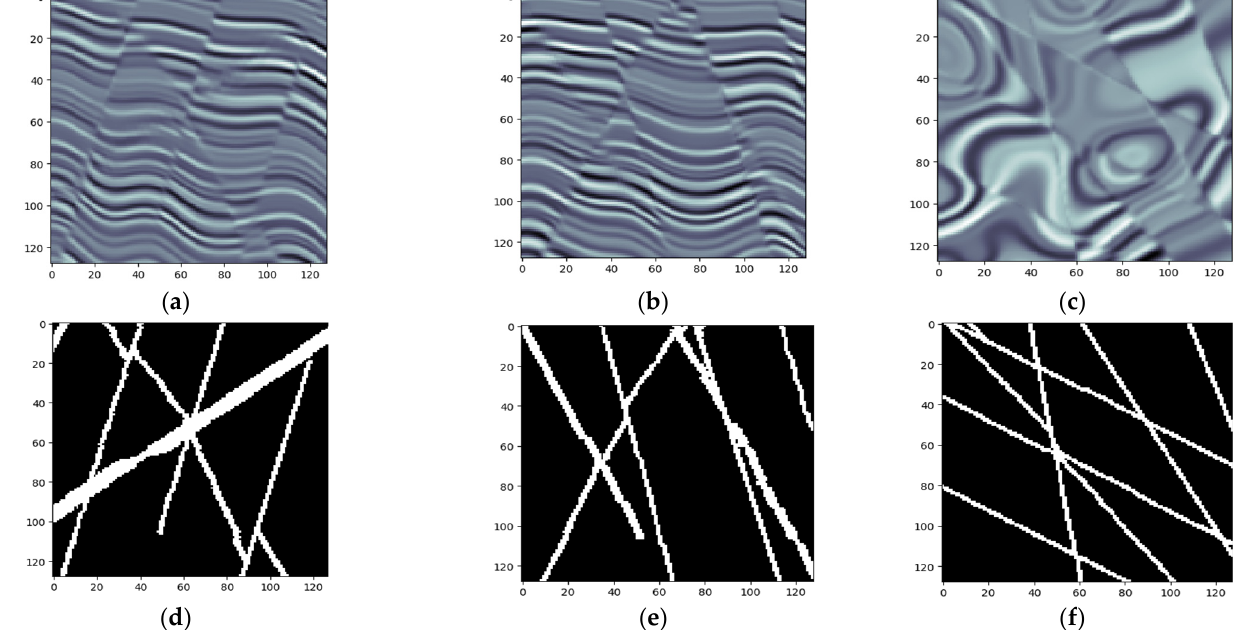
Figure 7. The labeled faults on the synthetic training data set. ( a ) Image in the inline direction, ( b ) image in the crossline direction, ( c ) time slice, ( d ) the corresponding labeled faults on image ( a ), ( e ) the corresponding labeled faults on image ( b ), and ( f ) the corresponding labeled faults on image ( c ).